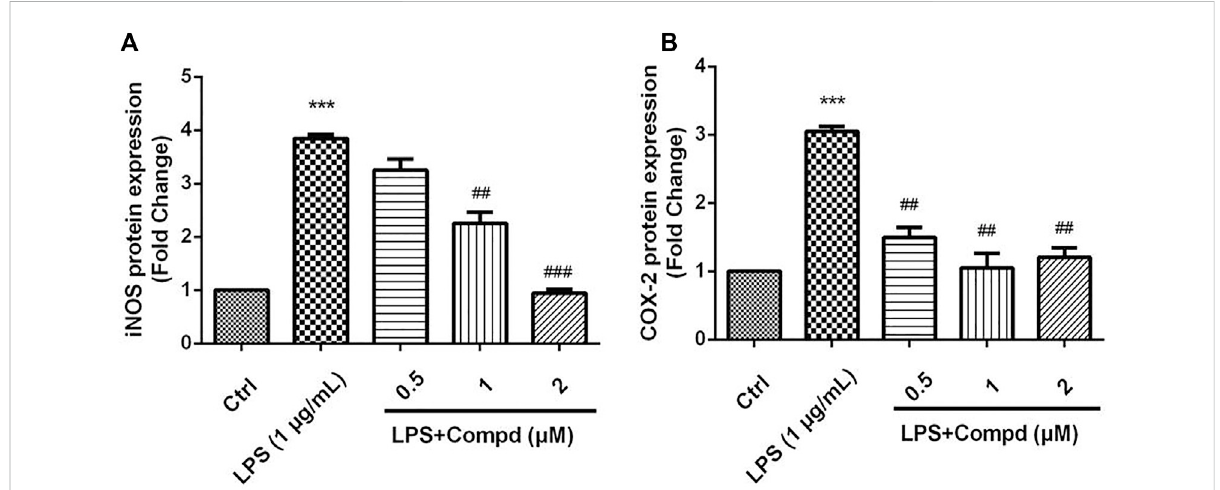
FIGURE 6 Analog 18 inhibitedtheexpressionofiNOSandCOX-2inLPS-inducedBV-2cells.Cellswerestimulatedby1 μ g/mLLPSwithorwithout18for24 h. (A) TheproteinexpressionsofiNOStreatedbydifferentconcentrationsof18weredeterminedbyWesternblotassay, (B) theexpressionsofCOX-2treatedby differentconcentrationsof18weredeterminedbyWesternblotassay.Thedataarerepresentedasamean±S.D.fromindependentexperimentsperformed